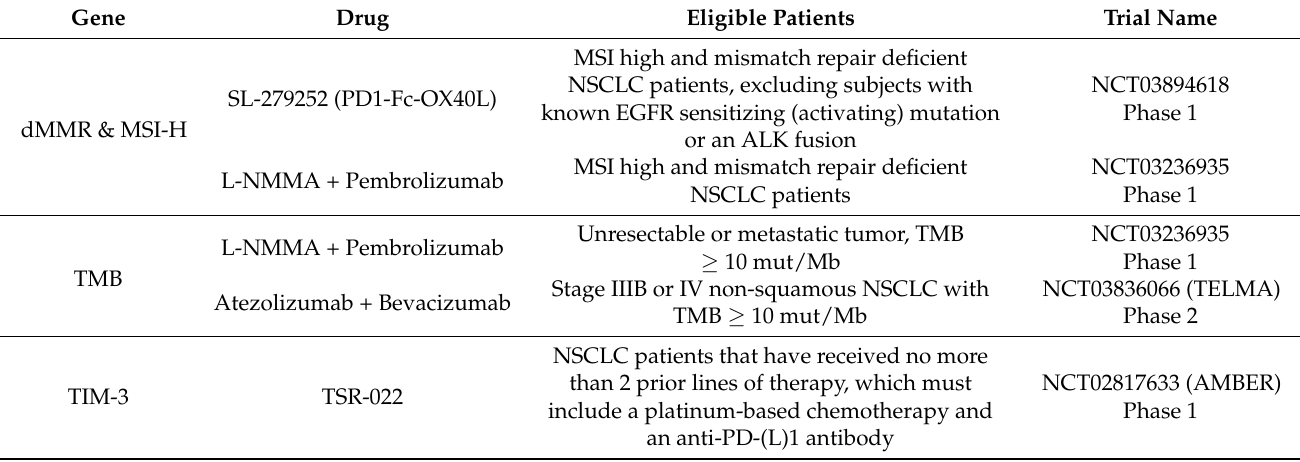
Table 4. Summary of ongoing clinical trials for novel immunotherapy biomarkers.